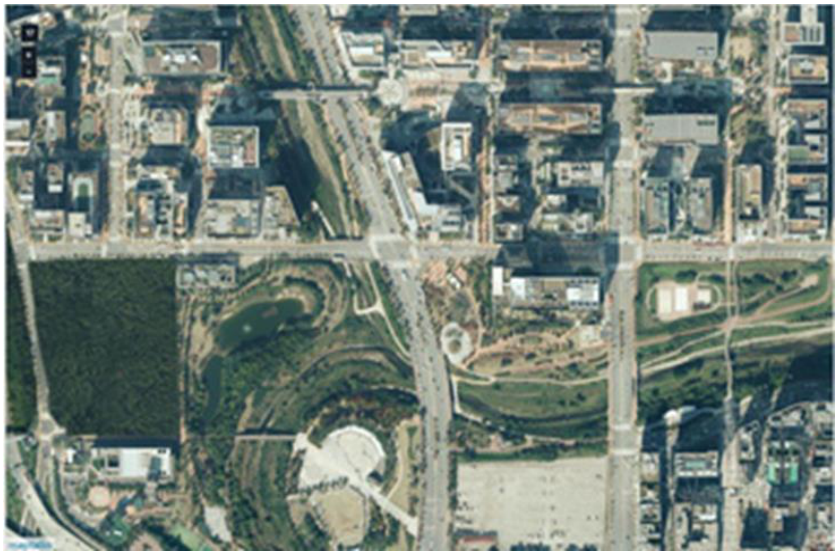
Figure 12. Web-based object visualization.